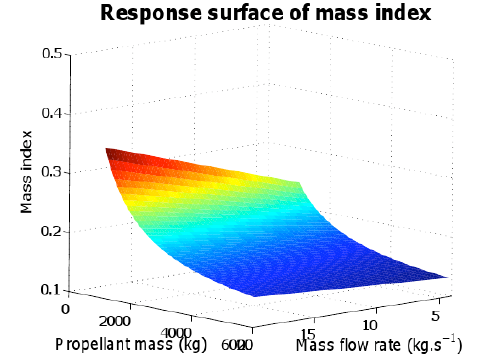
Fig. 6. Response surface of mass index (diameter and